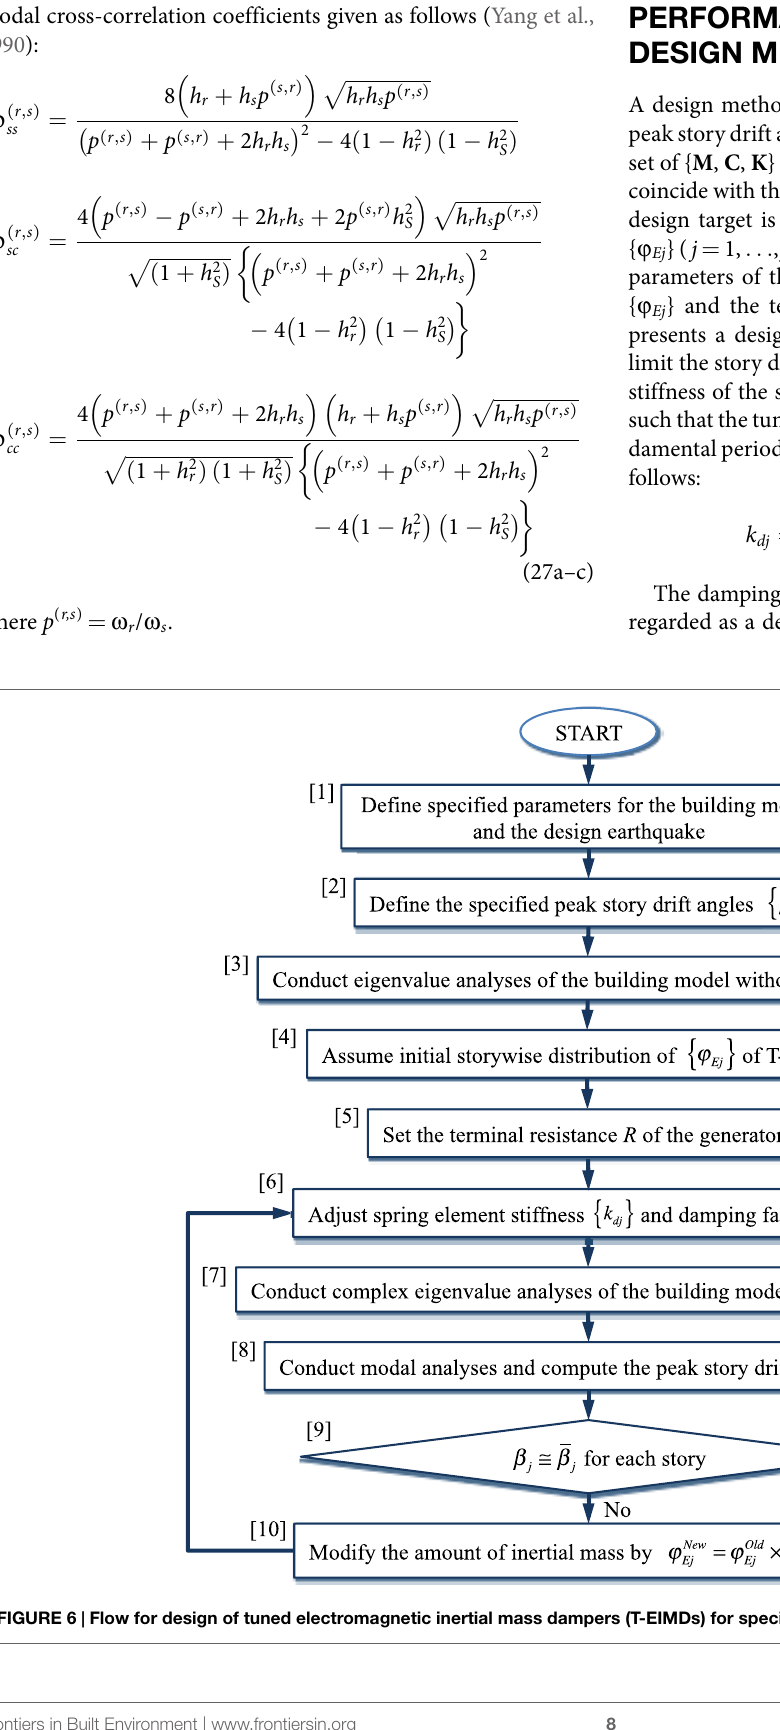
Frontiers in Built Environment |